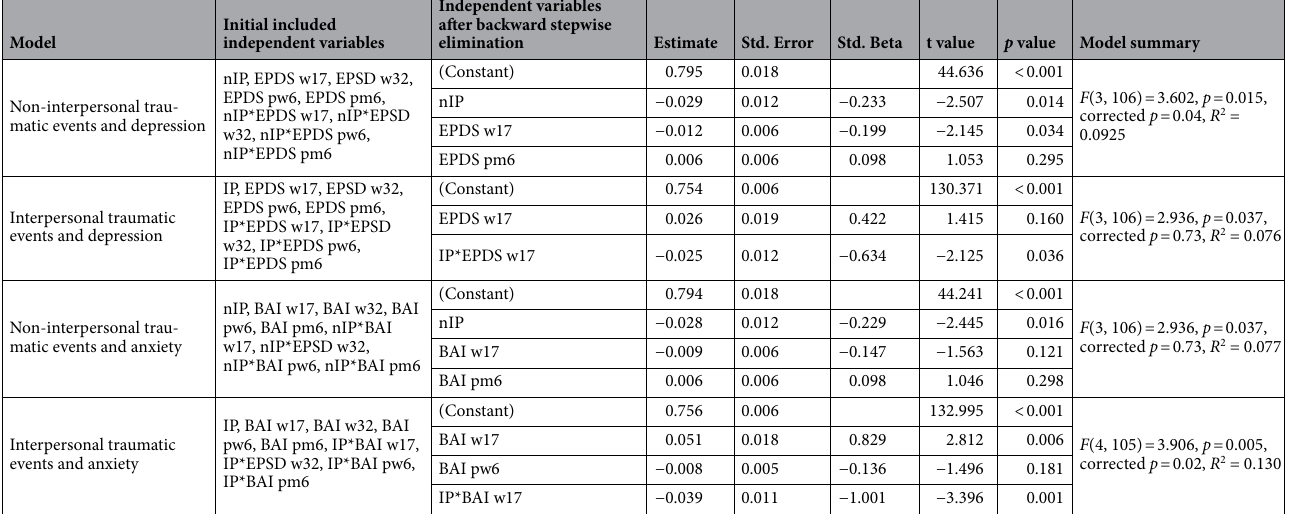
Table 2. Four separated multivariable linear regression models for systematically selecting variables for the final model. Look percentage is the common dependent variable in all four models. Significant variables of each model are included in the united model. Corrected p value is calculated based on the Holm-Sidak method. Std. Error, Standardized Error; Std. Beta, Standardized Beta; EPDS, Edinburgh Postnatal Depression Scale; BAI, Beck Anxiety Inventory; w17, antenatal 17 weeks; w32, antenatal 32 weeks; pv6, postpartum 6 weeks; pm6, postpartum 6 months; IP, interpersonal traumatic events; nIP, non-interpersonal traumatic